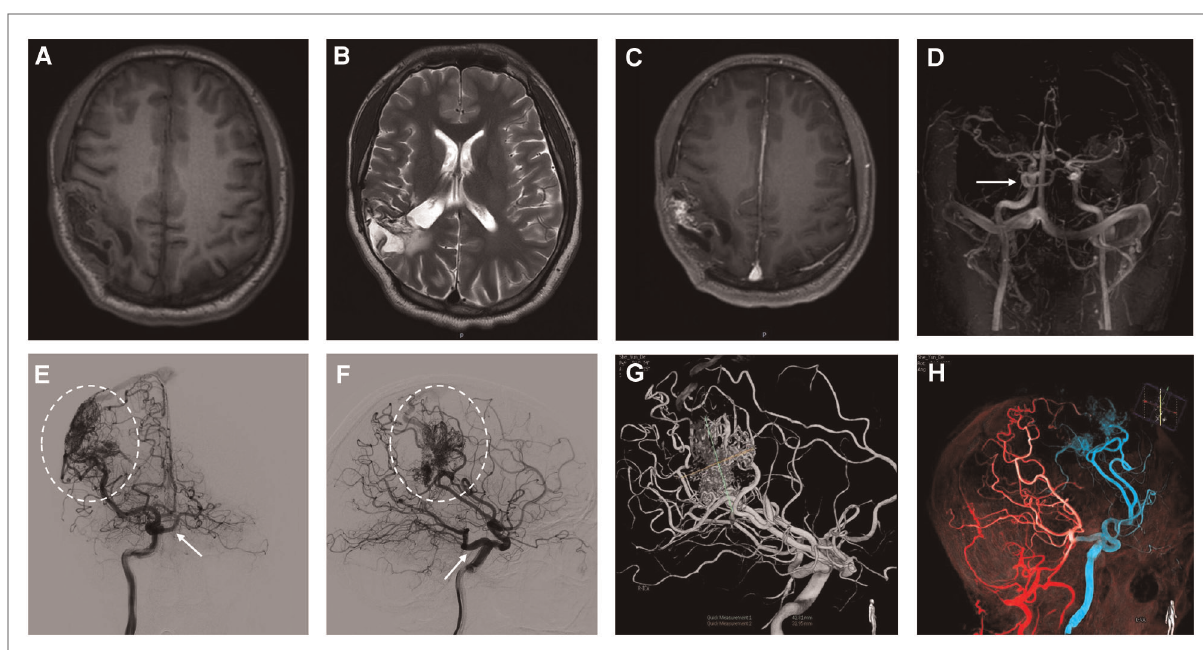
FIGURE 1 In the right parietotemporal lobe, an irregularly circular space-occupying lesion was found with slightly long T1 shadows ( A ). T2-weighted image shows a parietotemporal lesion with mixed signal characteristics ( B ). Enhanced MRI shows heterogeneous enhancement in the right parietotemporal lobe ( C ). The primitive trigeminal artery arose from the cavernous sinus segment of the right ICA ( D ). Initial right internal carotid artery injections, anteroposterior ( E ) and lateral views ( F ), show shunted fl ow to the cavernous sinus (arrow). Anteroposterior and lateral projection angiogram shows a right parietotemporal AVM supplied by the right middle cerebral artery drainage into the superior sagittal sinus ( E, F , dashed oval). 3-dimensional (3D) DSA arterial phase indicates in the lateral projection showing AVM lesion with 42.8 mm in size and PTA obtained after right internal carotid artery injection ( G ). Fused image of 3D DSA demonstrates the fl ow of the right ICA (blue), VA (red) ( H